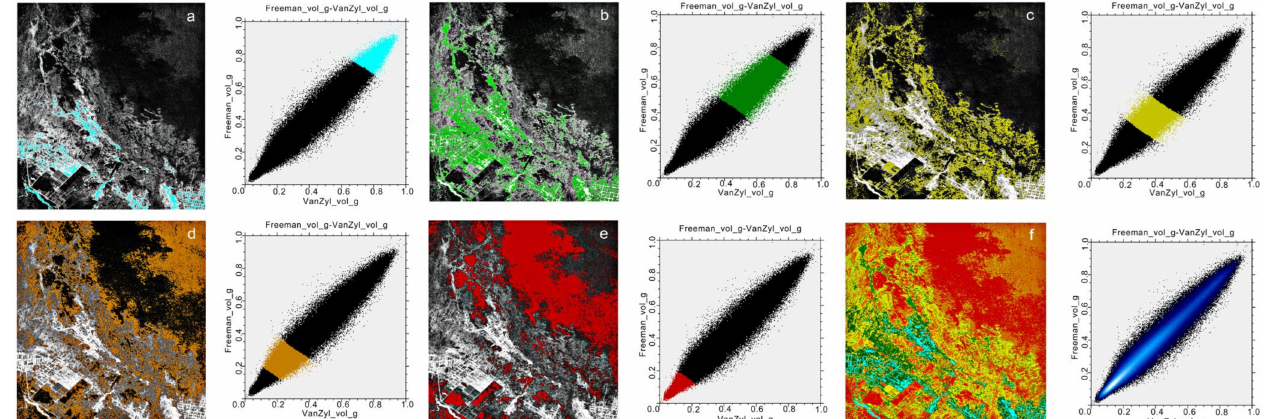
Figure 9. Illustration of different feature types and soil salinization contents in images in the VF feature space: ( a ) water bodies; ( b ) plant cover; ( c ) slight salinization; ( d ) moderate salinization; ( e ) severe salinization; ( f ) spatial distribution patterns of different levels of soil